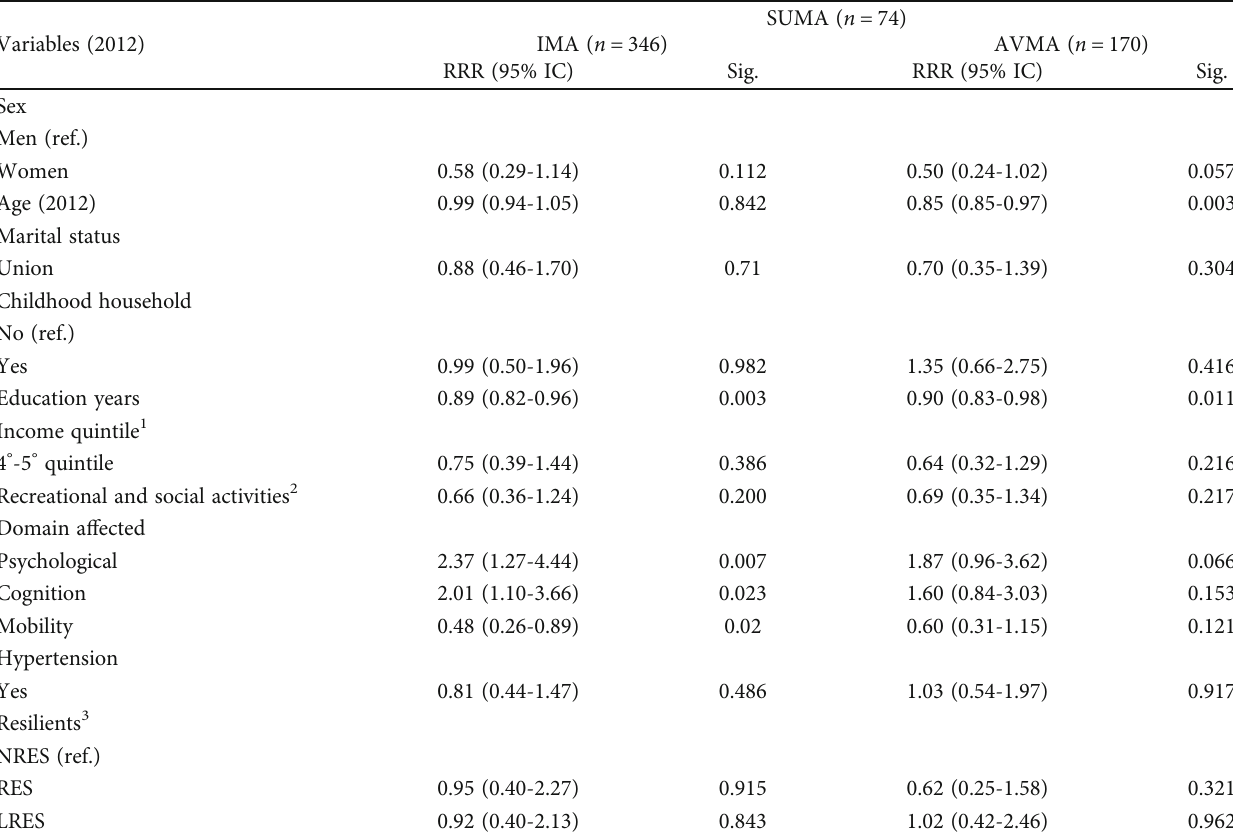
Table 4: Multinomial logistic regressions predicting successful memory aging ( n = 590